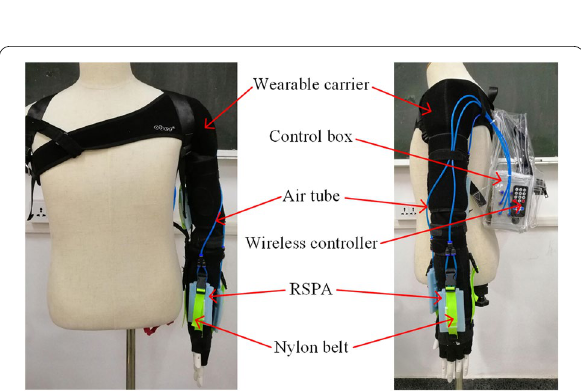
Figure 2 Prototype of wearable soft rehabilitation robot